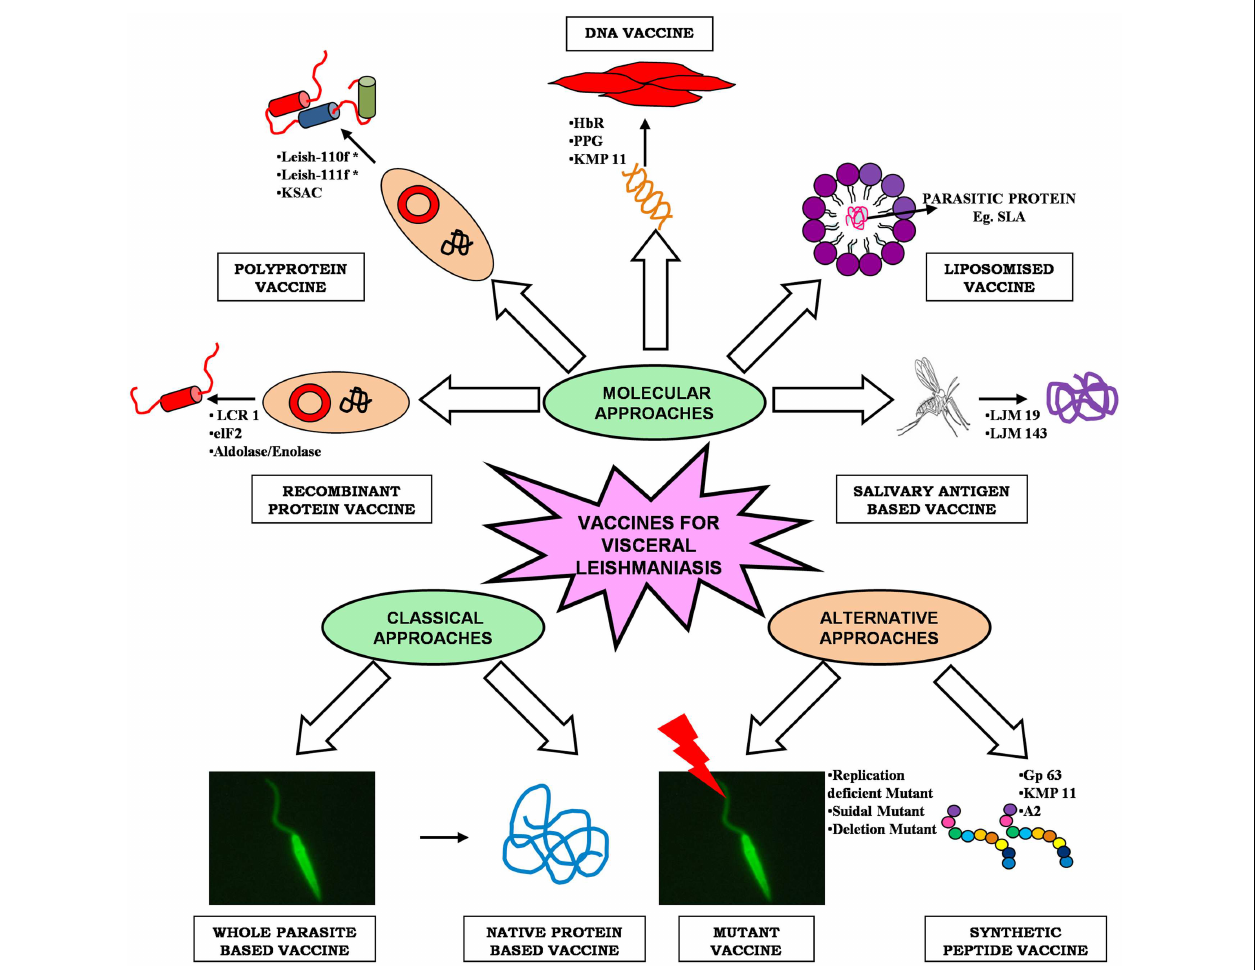
FIGURE 1 |An overview of different approaches of vaccine development for visceral leishmaniasis .